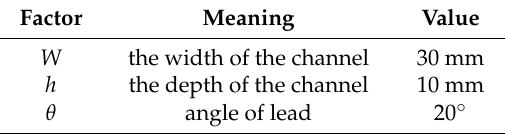
Figure 1. Structure of the extruder: ( a ) diagram of the extruder, and ( b ) spreading structure of the extruder.